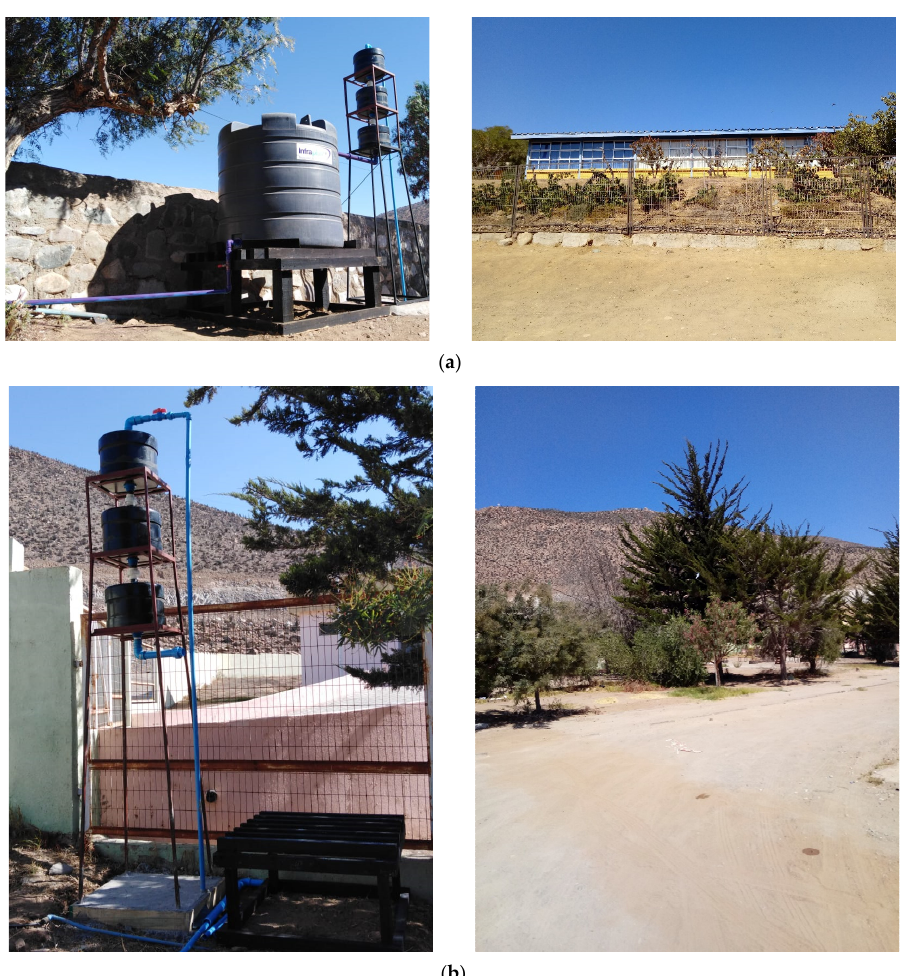
Figure 1. Greywater reuse system and irrigation area of Los Pozos ( a ) and José Santos Ossa school ( b ). The photographs on the right correspond to the area irrigated with treated greywater.